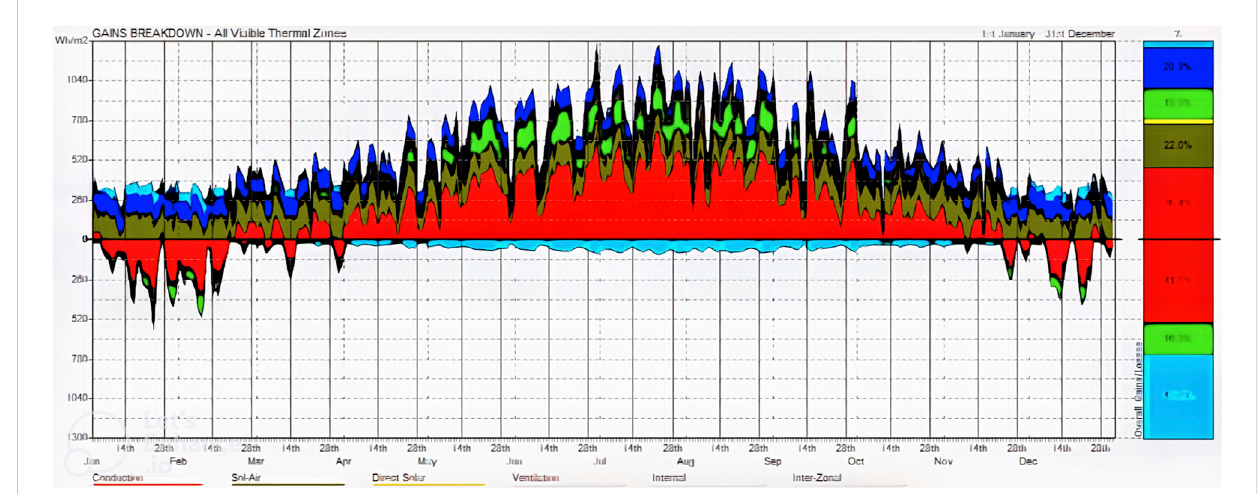
FIGURE 6 Gains breakdown in different thermal zones [w/m 2 ]. Red: conduction; yellow: direct solar; green: ventilation; blue: internal gains; sky-blue: inter- zonal gains.